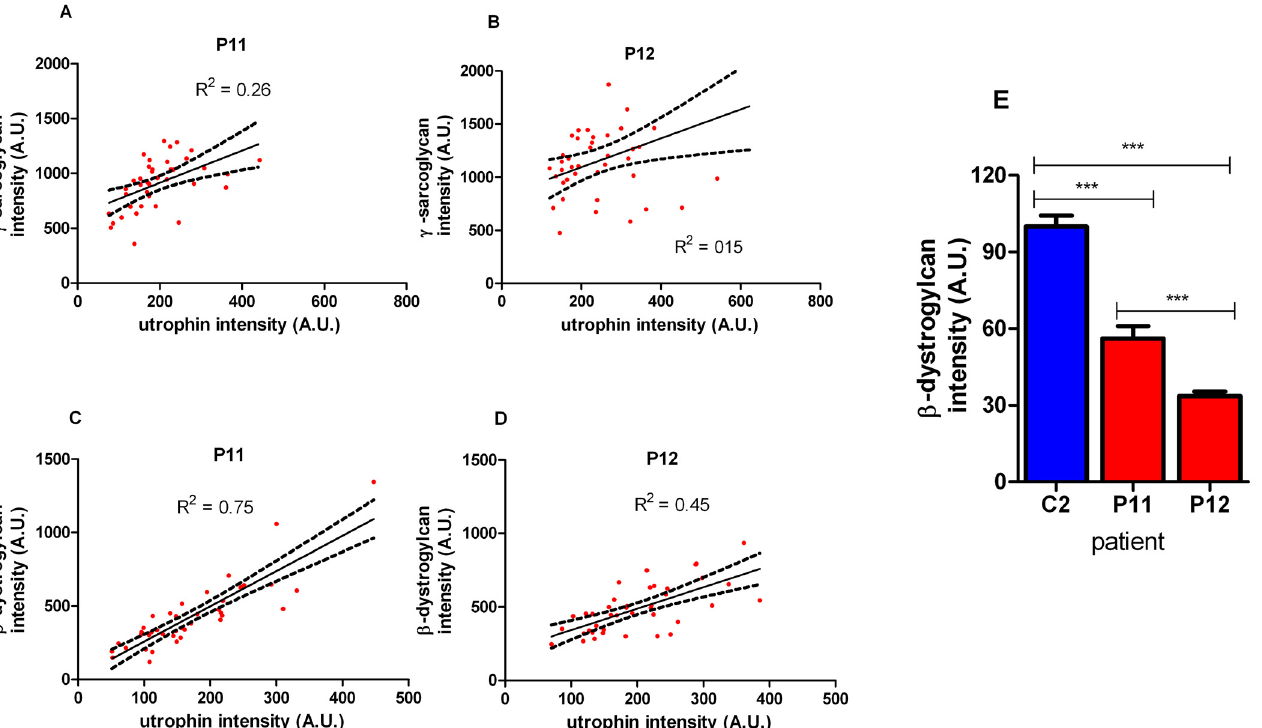
Fig 4. Correlation of utrophin immunostaining with β -dystroglycan and ɣ -sarcoglycan in muscle fibres. (A, B) ɣ -sarcolgycan intensity (arbitrary units; A.U.) on muscle fibres from 4 (P11) and 8 (P12) year old DMD muscle and (C, D) β -dystrogylcan intensity (A.U.) in muscle fibres from 4 (P11) and 8 (P12) year old DMD patients revealed significant correlations with utrophin using Pearson ’ s and Spearman ’ s test. Regression line with 95% confidence intervals is shown. (E) The intensity of β -dystroglycan was significantly reduced in DMD P11 and 12 following normalisation to spectrin and expression relative to control muscle biopsy, C2. (One Way ANOVA with Tukey ’ s: ** p < 0.01; *** p <